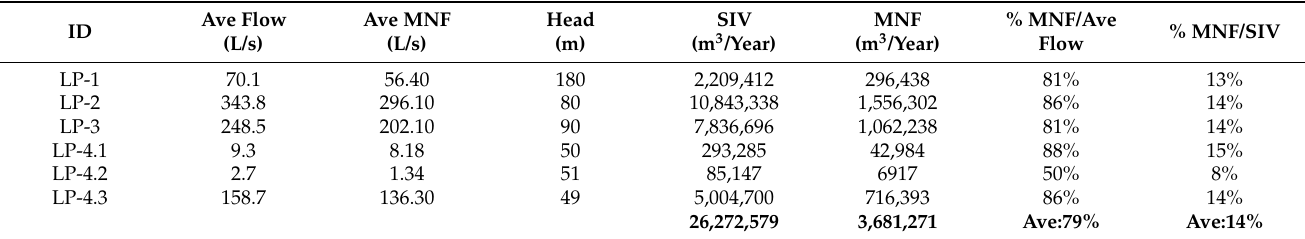
Table 2. Flow analysis results for the district metered